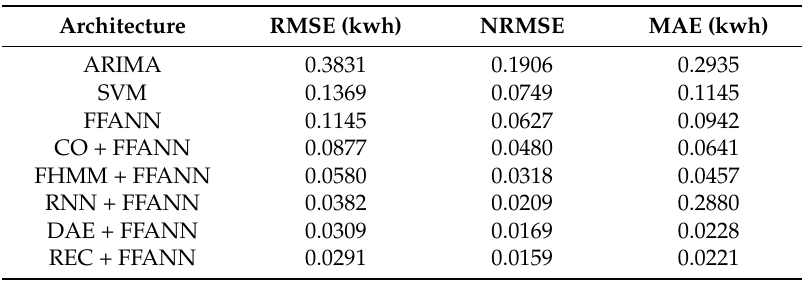
Table 2. Load Forecasting Performance Comparison for the seen home.